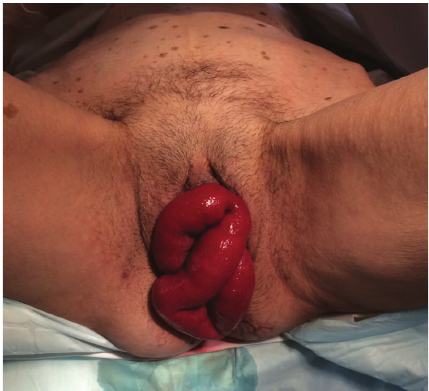
Figure 1: Small bowel evisceration through the vagina.